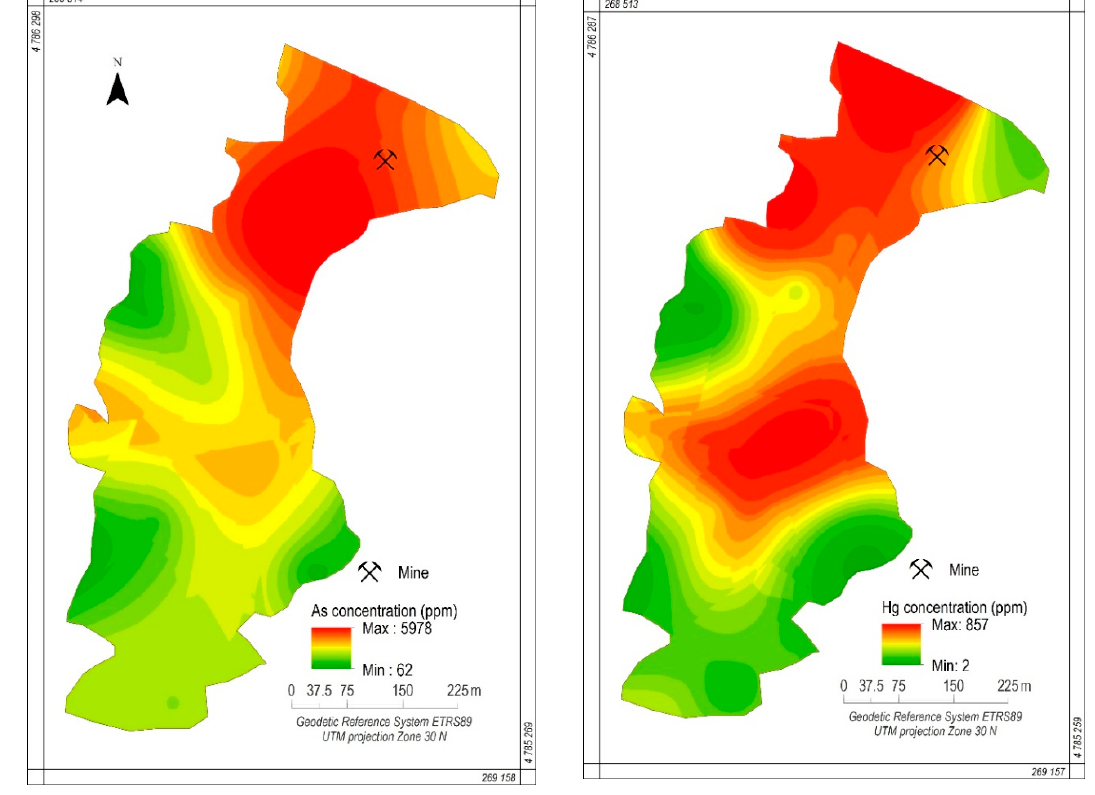
Figure 6. Kriging interpolation. Left : As; and Right : Figure 6 . Kriging interpolation. Left: As; and Right: Hg.